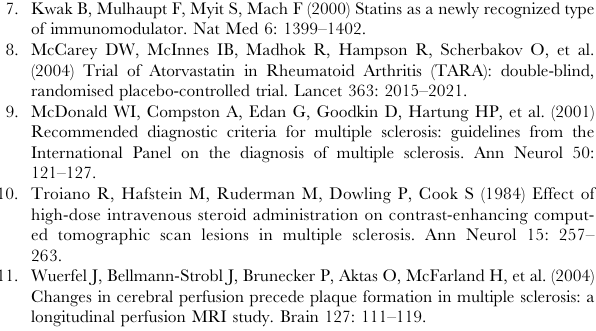
Pain (back, chest, joints)